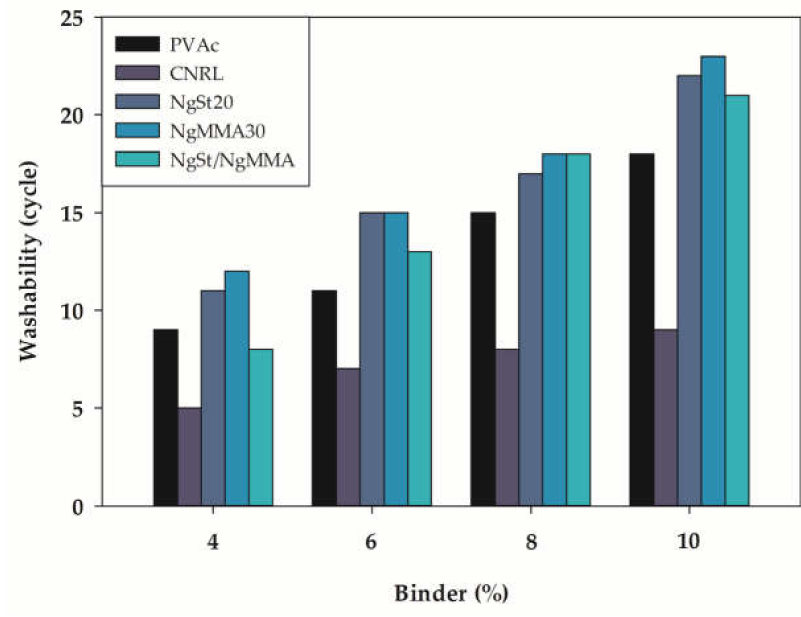
Figure 3. Washability of Various Types of NRL Binders at Various